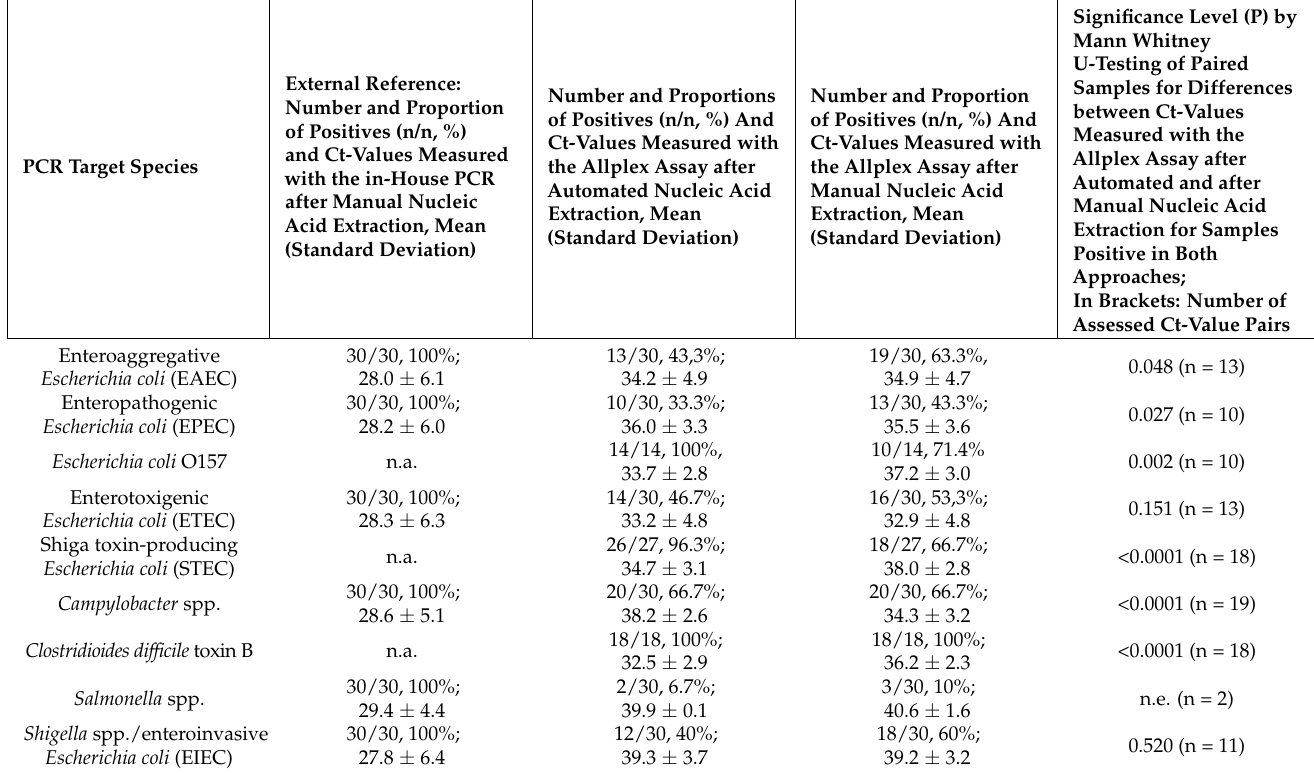
Table 4. Comparison of the Ct values with the Allplex assays after automated and manual nucleic acid extraction. Available Ct values from the in-house PCRs have been prefixed as external references. Varying denominators arose from the differing availabilities of the residual sample